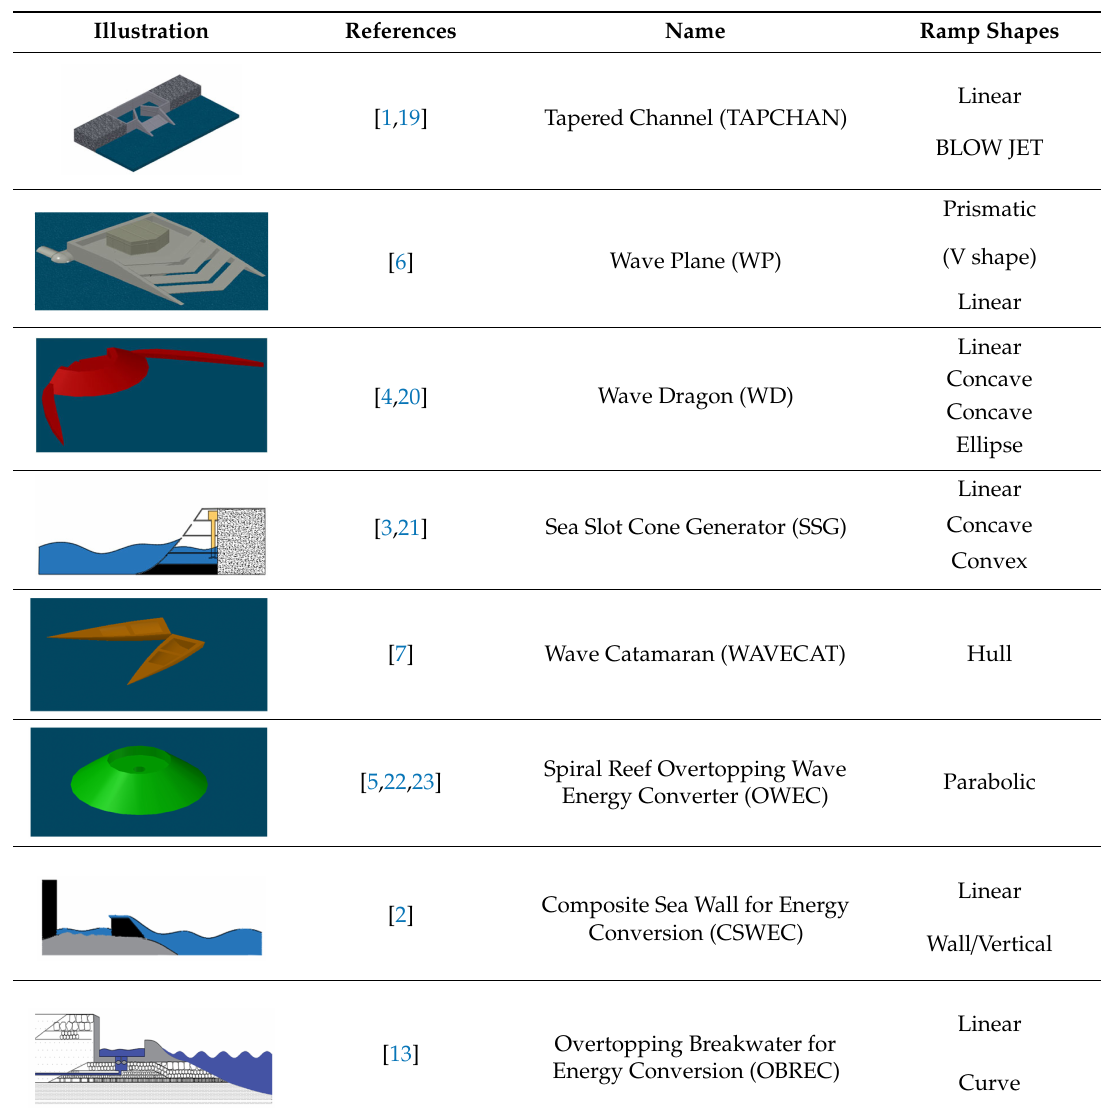
Table 1. List of Overtopping Wave devices and their ramp